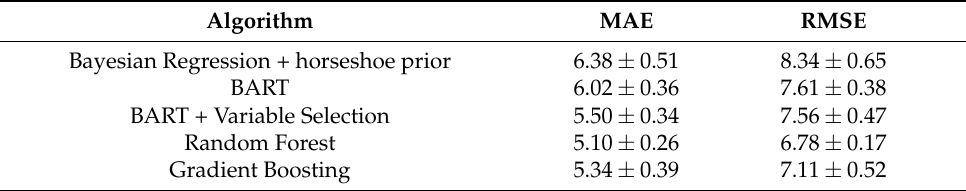
Table 3. MAE and RSME of different models estimated through repeated 5-fold cross